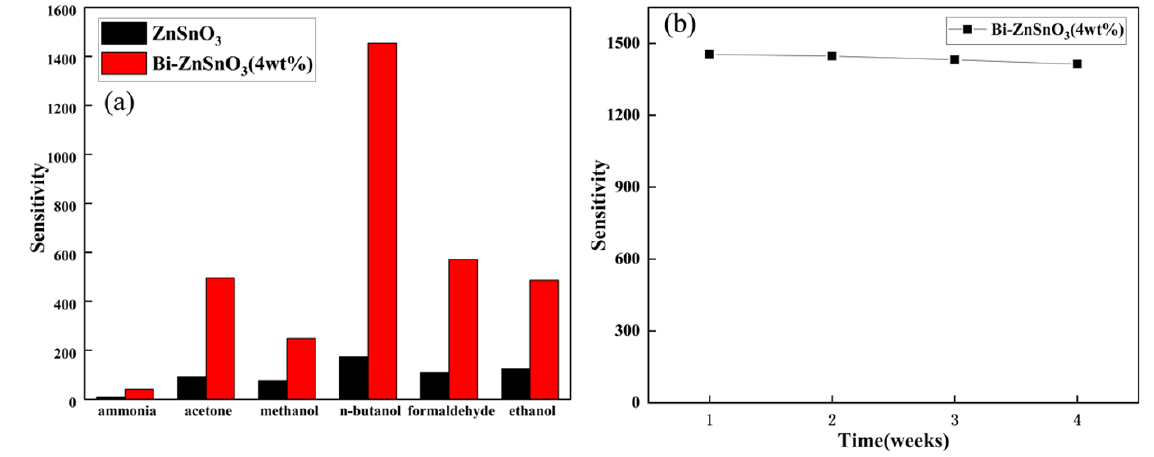
Figure 10. ( a ) Comparison of selectivity test results of pure ZnSnO 3 and Bi-ZnSnO 3 (4 wt%) and ( b ) repeatability test results of Bi-ZnSnO 3 (4 wt%). ( b ) repeatability test results of Bi-ZnSnO 3 (4 wt%).